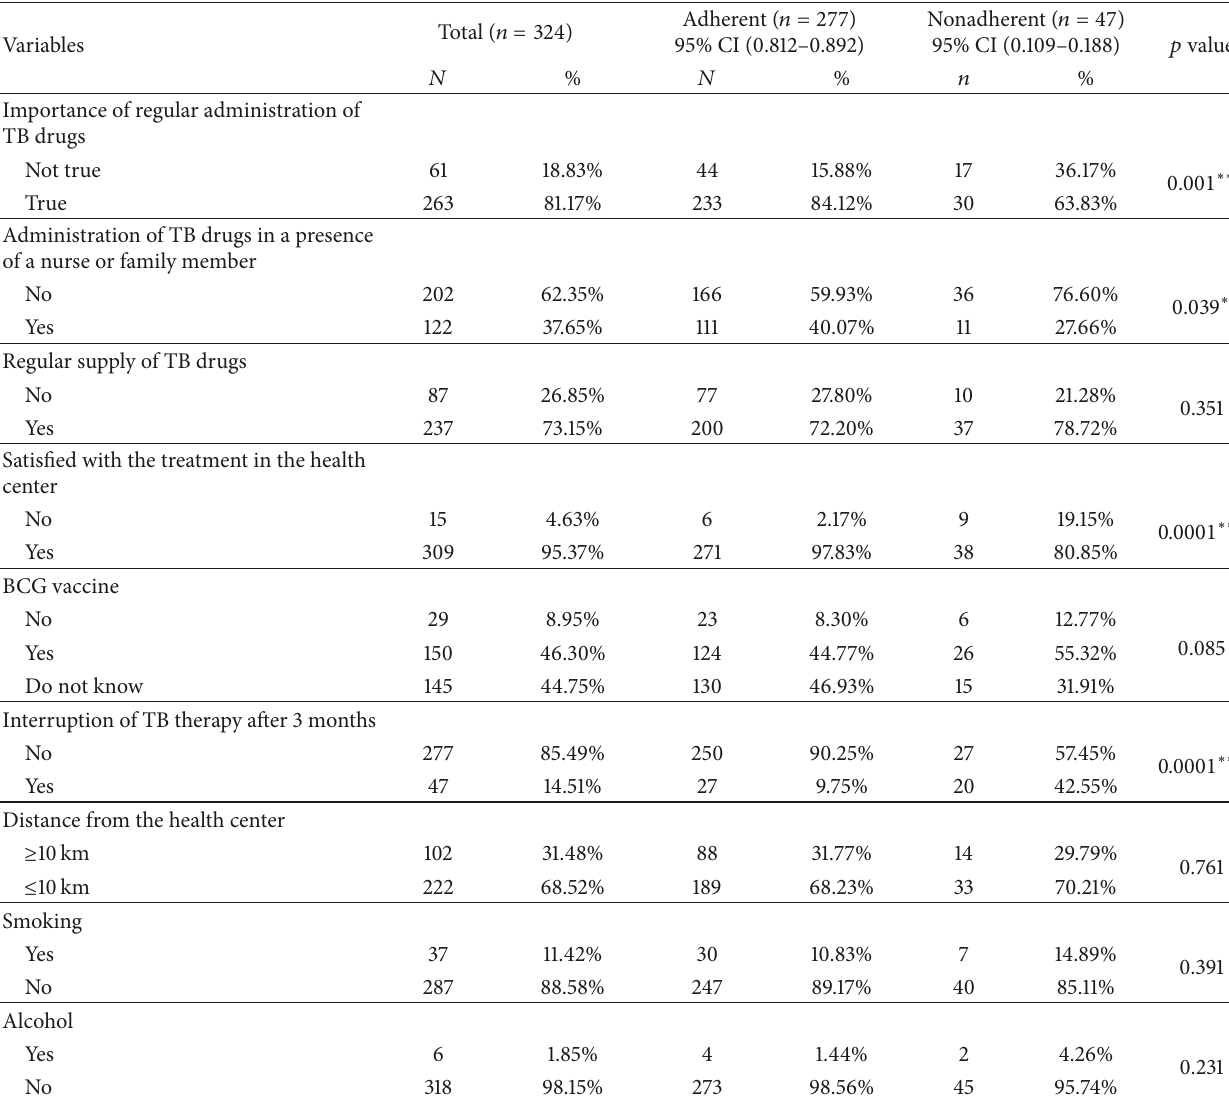
Table 4: Knowledge of TB drug compliance and risk behavior of TB